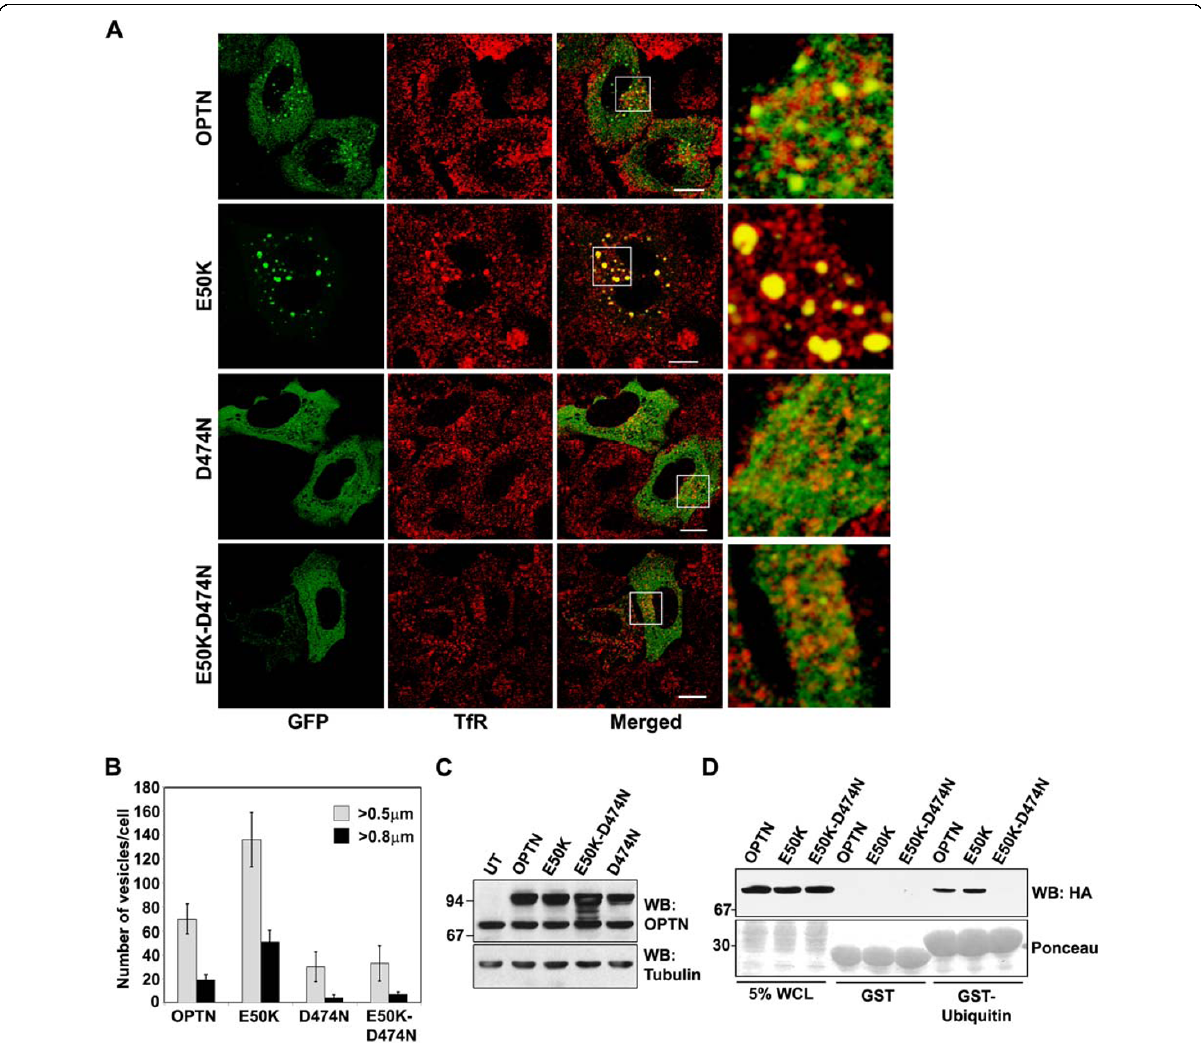
Figure 3 The UBD is required for localization of optineurin to RE . (A) HeLa cells were transfected with GFP-tagged wild type optineurin or its mutants and stained for TfR. Ubiquitin binding defective D474N and E50K-D474N mutants are not recruited to RE as indicated by a lack of colocalization with TfR. Note the absence of large vesicular structures in E50K-D474N mutant. Bar; 10 μ m. (B) The number of vesicles in cells expressing GFP tagged wild-type and mutant optineurin. (C) Western blot showing expression of GFP tagged optineurin and its mutants, probed with optineurin antibody. (D) E50K-D474N mutant does not bind ubiquitin. GST-ubiquitin or GST alone bound to glutathione agarose beads were incubated with lysates of HeLa cells transfected with wild type optineurin or its mutants. The bound proteins were eluted and immunoblotted with anti-HA antibodies. WCL, 5% whole cell